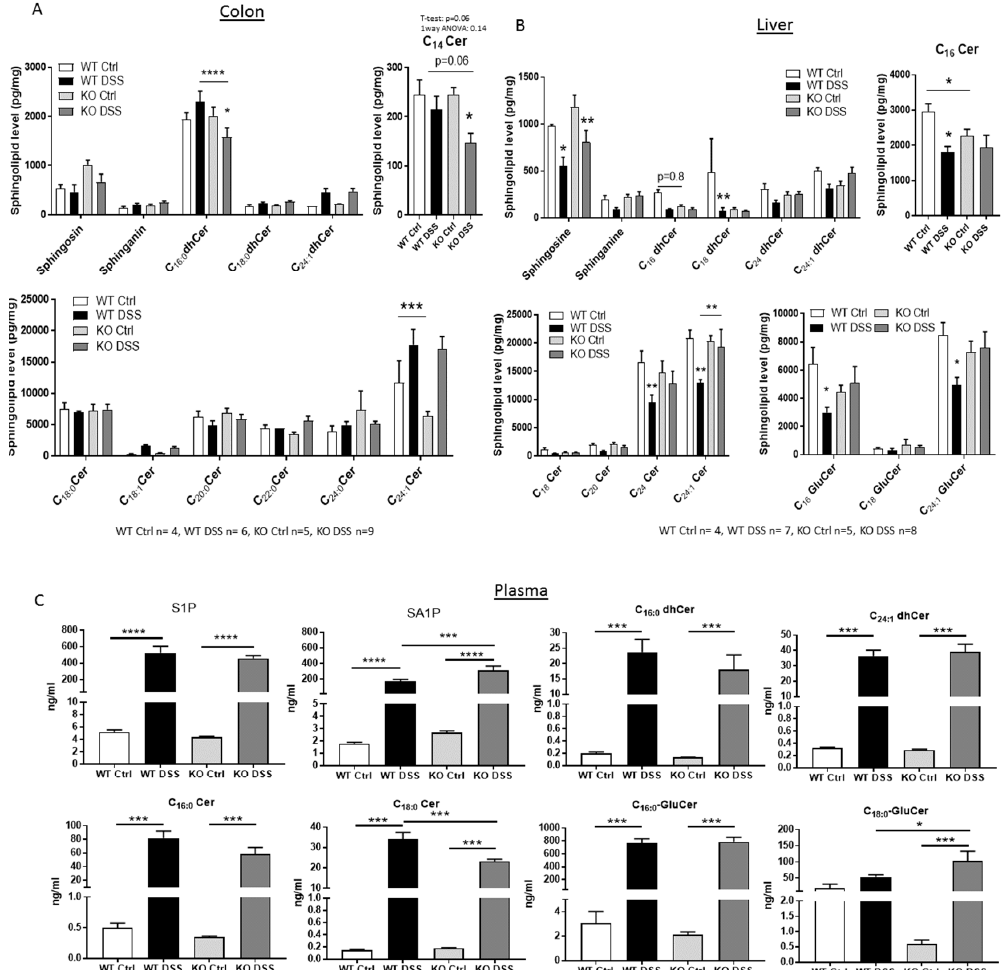
Figure 3. Sphingolipid levels in picogram per milligram tissue of colon ( A ) and liver ( B ) and nanogram per milliliter in plasma ( C ). Data are mean of n = 4–9 ± SEM; statistical analysis was performed by one-way ANOVA. p * = 0.05, p ** = 0.01, p *** = 0.001, p **** = 0.0001.